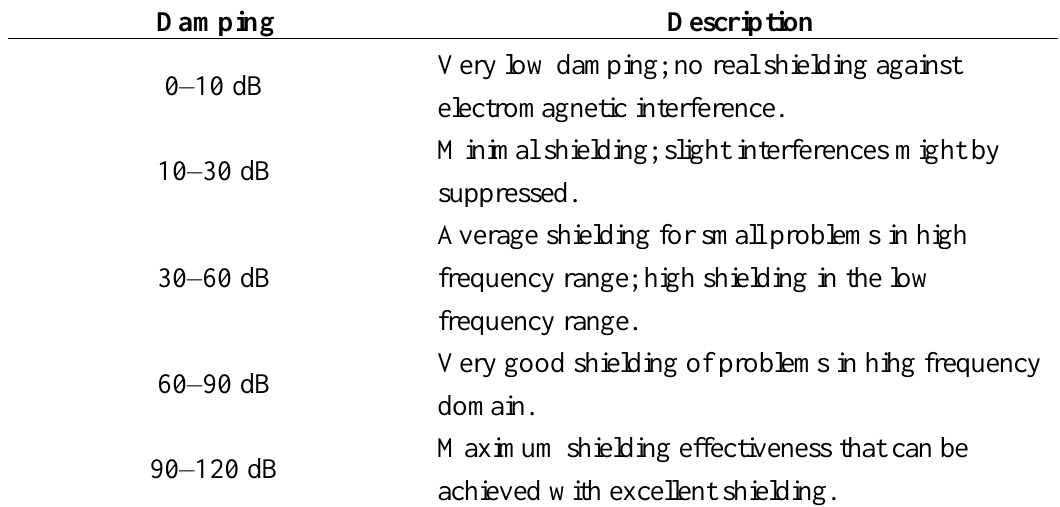
Table 2. Description of damping strength and shielding effectiveness according to